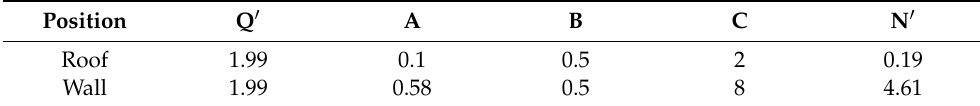
Table 4. Calculation statistics of stability coefficient N ′ .